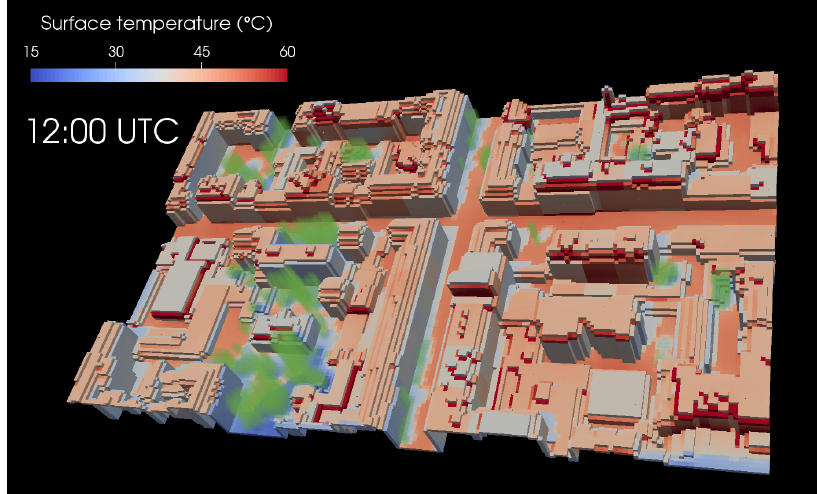
Figure 14. Modelled surface temperatures for the entire domain on 3 July at 12:00UTC. Green areas represent vegetation